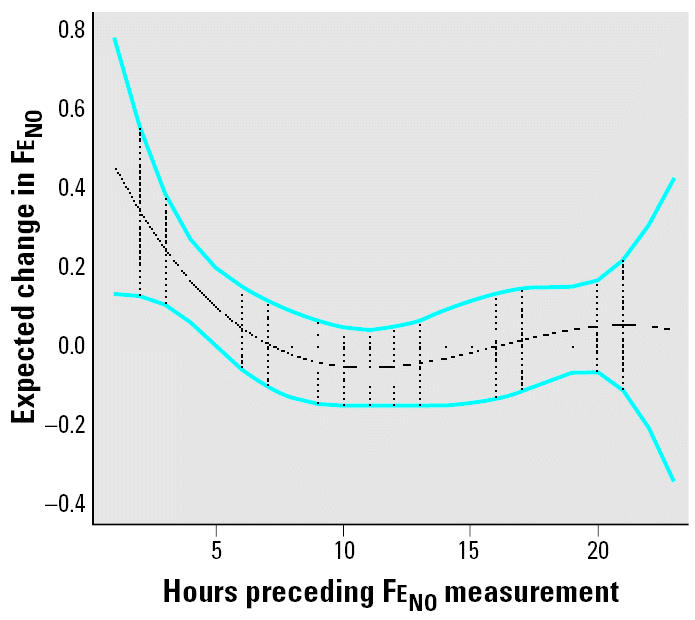
Estimated lag effect of hourly personal PM2.5 on FeNO. Estimates are based on a 4th-degree linear mixed-effects polynomial distributed lag model with AR(1) correlation structure. Expected changes in FeNO correspond to a 1-IQR (24 μg/m3) change in PM2.5. Blue bands indicate pointwise 95% CIs. Vertical dashes represent hourly measurements. All estimates are adjusted for personal temperature and relative humidity.